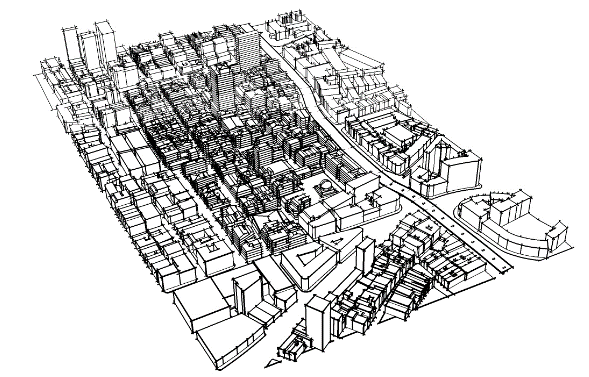
Figure 1. The existing site at Bhendi Bazaar on the Island City of Mumbai.